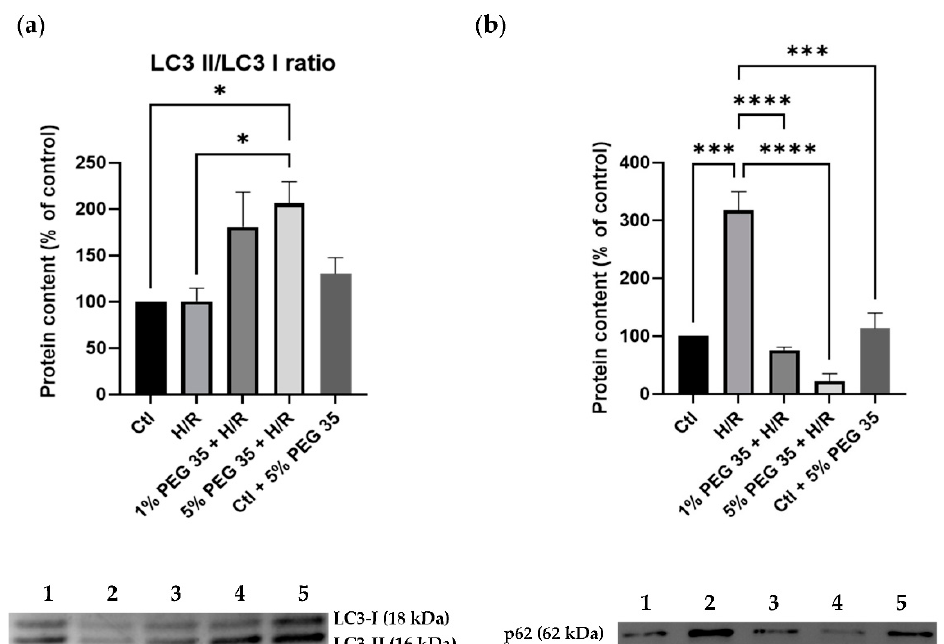
Figure 4. Autophagy-related protein markers in HepG2 cells. ( a ) Representative Western blot for LC3 I and LC3 II and respective LC3II/LC3I ratio quantification. ( b ) Representative Western blot for p62 and respective quantification for: 1-Ctl; 2-H/R; 3–1% PEG35 + H/R; 4–5% PEG35 + H/R; 5-Ctl + 5% PEG35. The values shown represent the mean ± SEM of 3 independent experiments. * p < 0.05; *** p < 0.001; **** p < 0.0001.